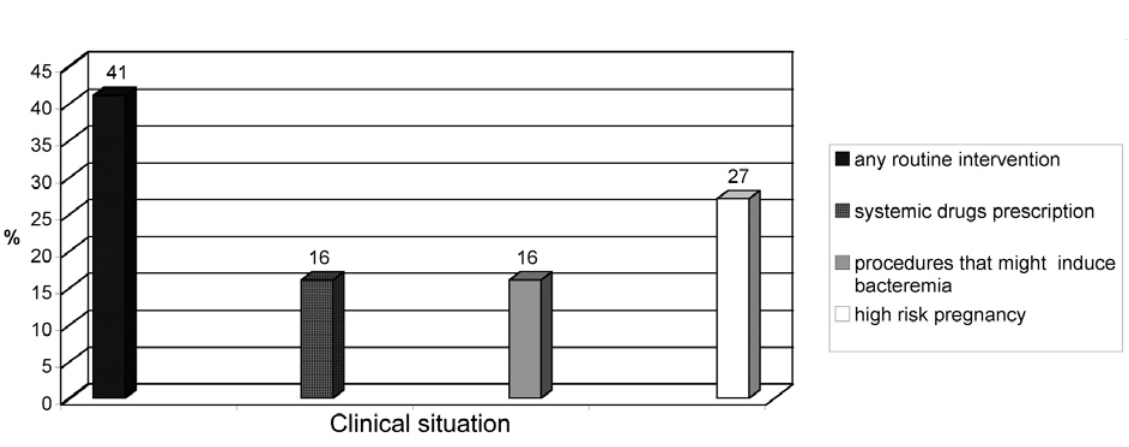
FIGURE 3- Clinical situations in which dentists (n=37) would like to previously consult the